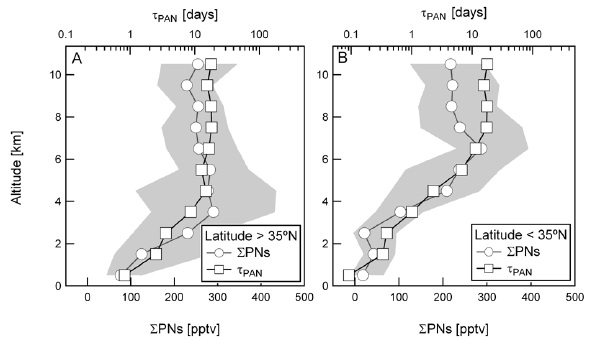
Figure 4 : Median vertical profile in Σ PNs (grey, -o-) and PAN instantaneous lifetime ( τ PAN ) with respect to thermal dissociation, photolysis, and reaction with OH (black, -□-) as observed during the INTEX-B field campaign over the North Pacific during the Spring of 2006 (April-May), North of 35ºN (left panel) and South of 35ºN (right panel). The solid line depicts the median value in 1 km altitude bins and the shaded regions represent the interquartile range.